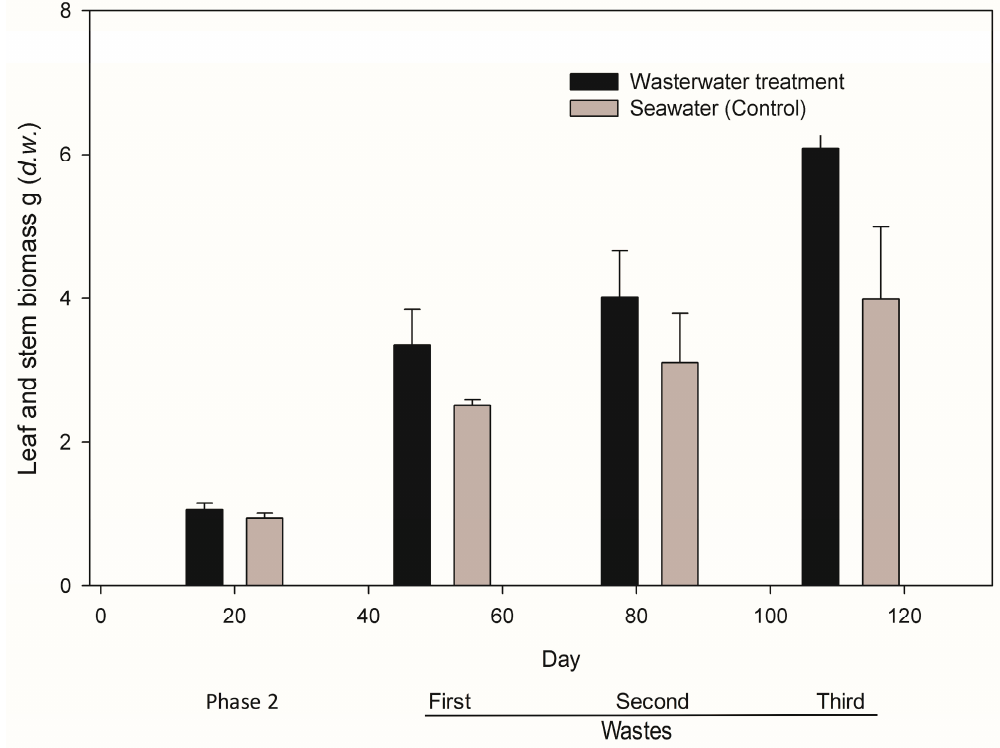
Figure 3. Efficiency of nutrient removal (nitrogen compounds and phosphates) in the interstitial water alters the first, second, third, waste of secondary urban residual water treated Phase II: Afforestation and conditioning stage.